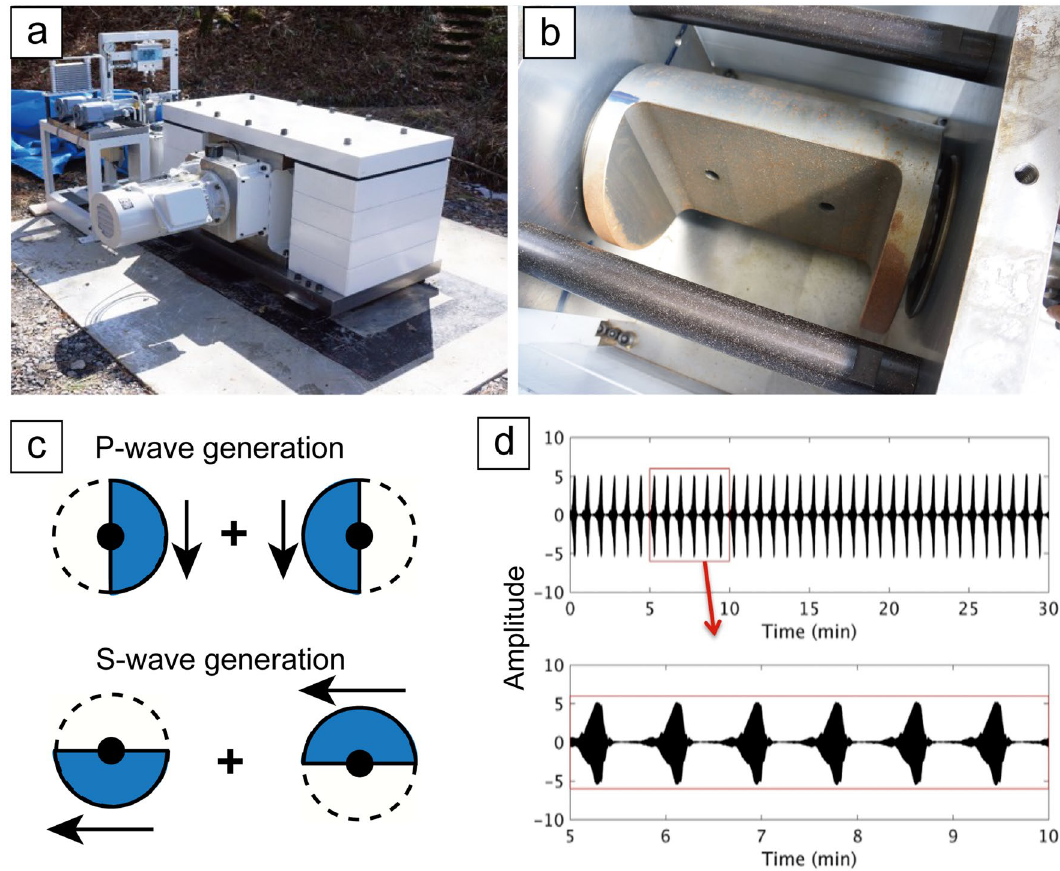
Figure 1. Continuous controlled seismic source system. ( a ) Picture of the continuous source system. ( b ) The eccentric rotating weight of the same source type with larger force. ( c ) Conceptual diagram of vertical and horizontal motions using our monitoring system based on the rotation direction of the eccentric mass. Blue indicates the mass position. ( d ) Chirps generated every 50 s by the source system. The rotation direction is switched every 2